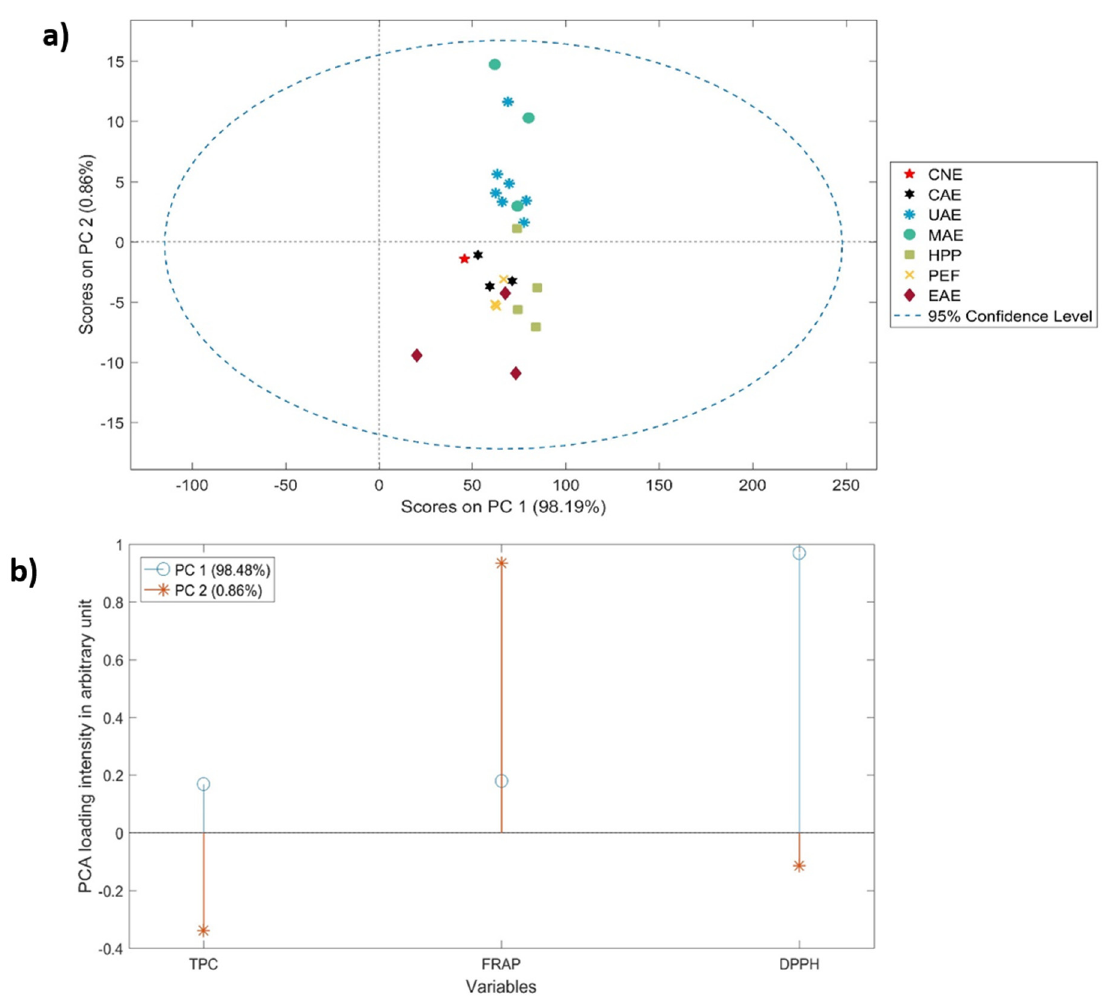
Figure 3. ( a ) Principal component analysis (PCA) score plot of PC1 and PC2; ( b ) PCA loading intensity plots based on the contents of the total phenolic content (TPC), and antioxidants (DPPH and FRAP) detected in the buckwheat hull extracts using different extraction strategies.